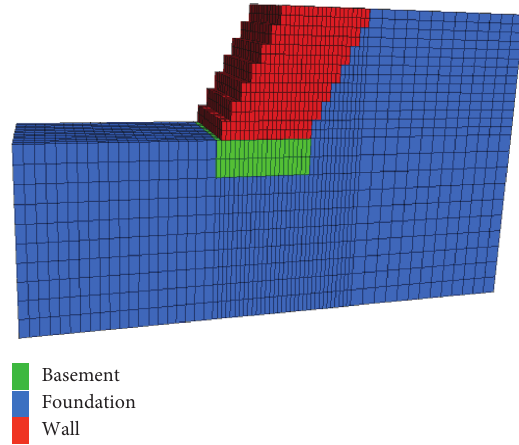
Figure 1: Elements of the calculation model.